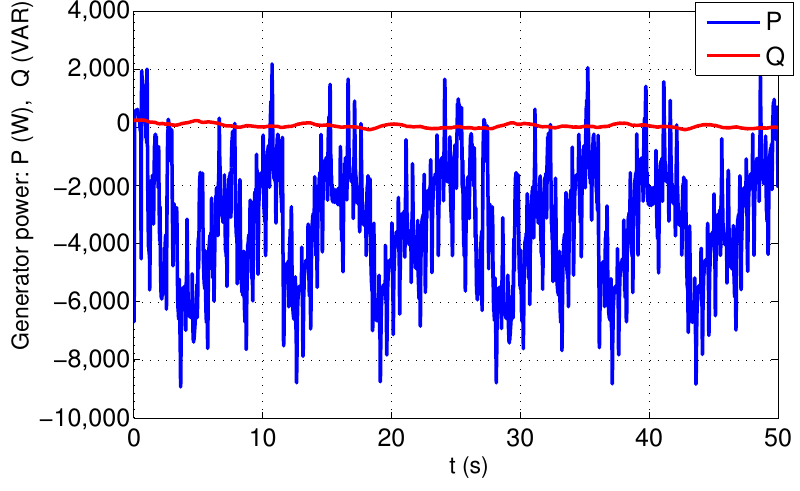
Figure 11. Generated active and reactive powers for the wind profile of Figure 5.